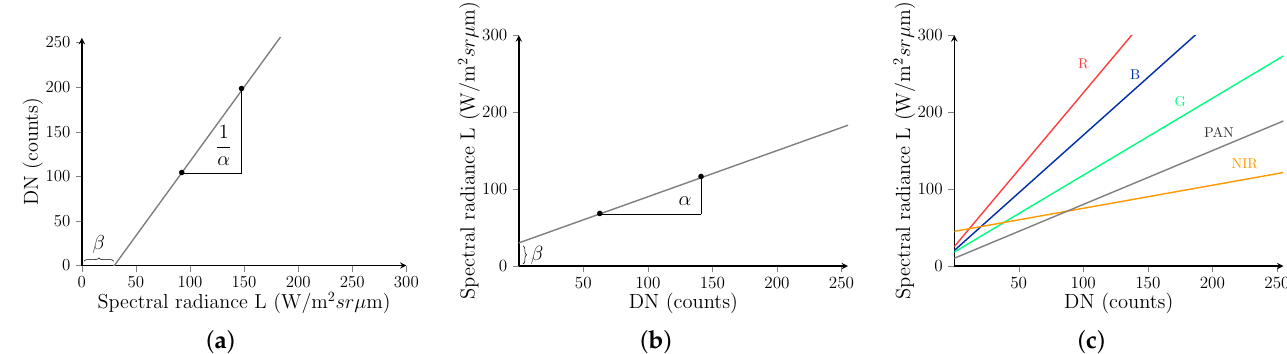
Figure 1. Forward and inverse trans-characteristics for data-format conversion: ( a ) packed fixed-point DN counts as a function of floating-point spectral radiance, Equation (1); ( b ) floating-point spectral radiance as a function of packed fixed- point DN counts, Equation (2a); ( c ) inverse trans-characteristic of all MS bands together, including Pan. If the wordlength of L min ) / ( 2 p DN is p ( p = 8 in the present case), α and β are equal to ( L max 1 ) and to L min , respectively. The intercept in − − ( 2 p L min L min ) β / α = ( a ) is equal to 1 ) / ( L max − − · − −